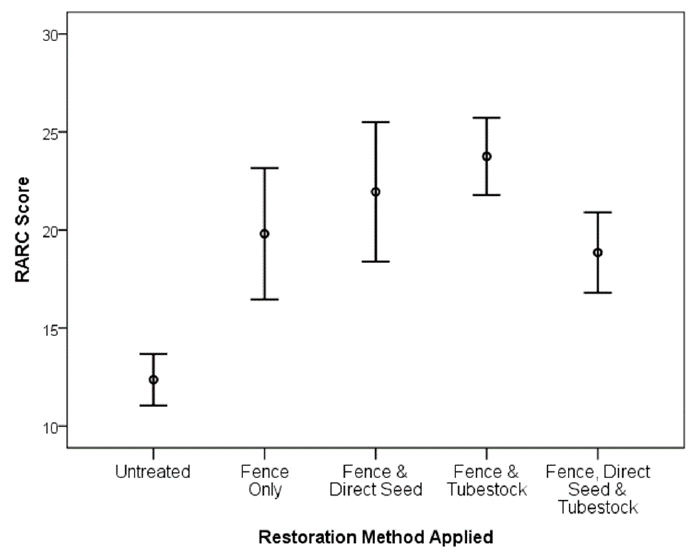
Figure 2. Mean riparian vegetation condition (RARC) scores 10 years after restoration for sites restored as part of the Bidgee Banks Restoration Project (BBRP) using four restoration methods (see Table 1). Untreated site scores are provided as a comparison. Error bars represent ± SE. A heathy site RARC score is